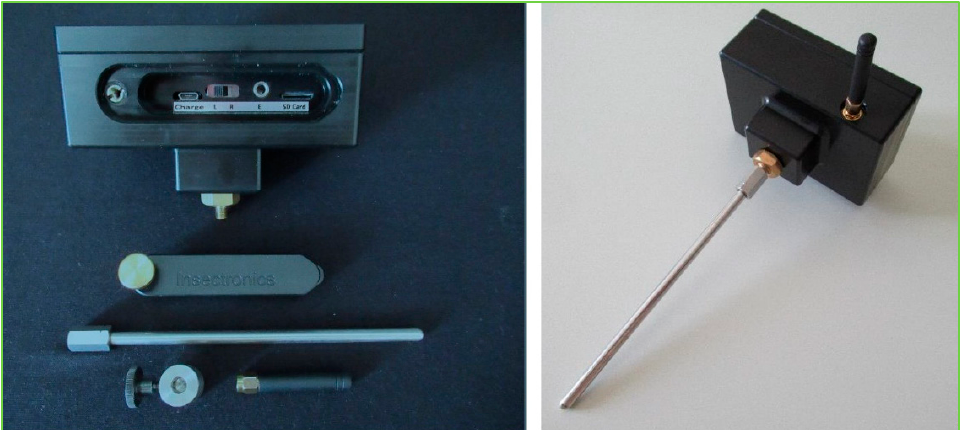
Figure 2. The main black box on the left is the recorder, which contained the secure digital (SD) card, antenna for communication, adapter, and waveguide; the acoustic sensor assemble is shown on the right (TreeVibes manual, Insectronics.net (accessed on 15 January 2020)).